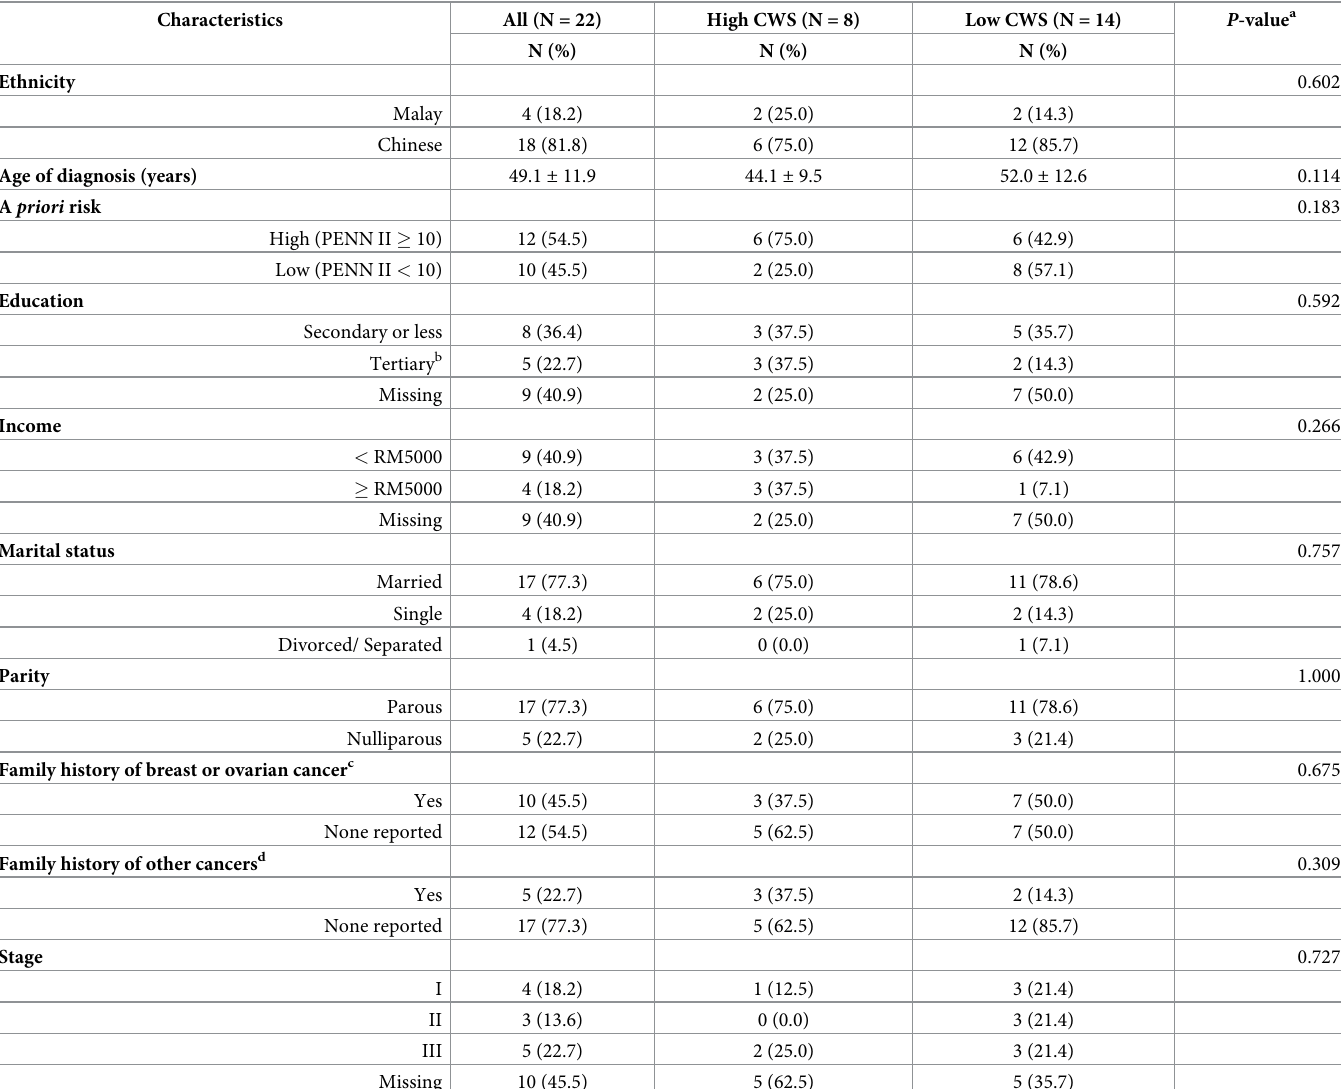
Table 3. Cancer worry scores among carriers at post-questionnaire (N = 22).